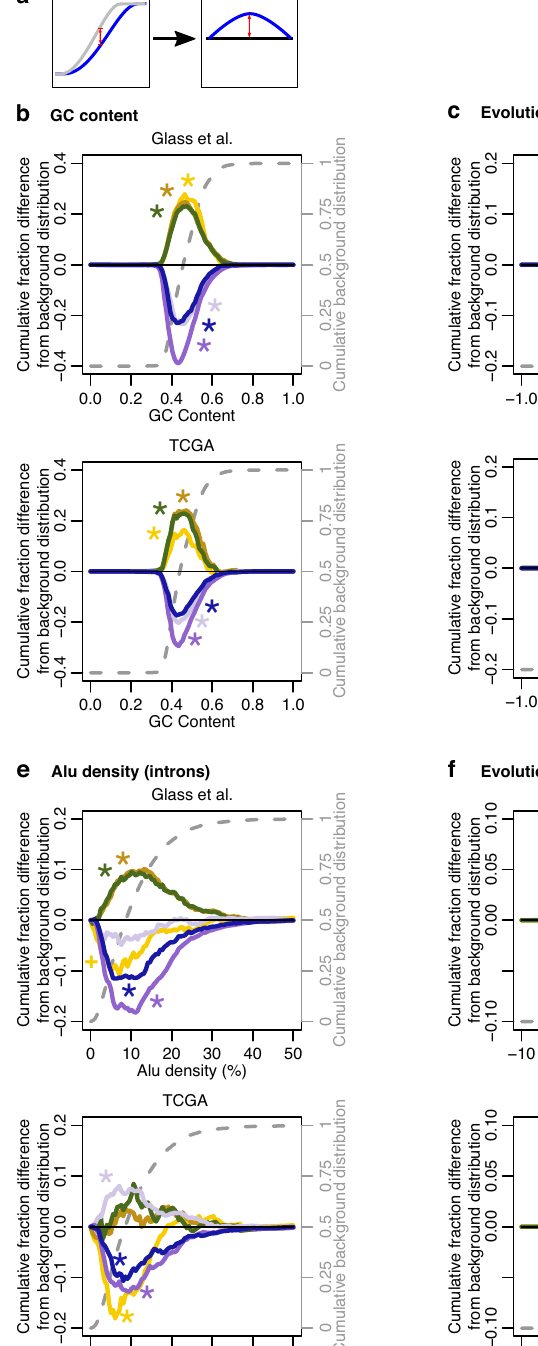
valueswhilenegativevaluesindicateashiftofthedistributiontowardlowervalues. Plots depict analyses of GC content ( b ), evolutionary conservation ( c ) and repeti- tive element densities ofMIR( d ) and Alu( e )elements, for the geneswith non-zero respective densities. f Evolutionary conservation of the mCpGs that are correlated with genes at proximal, intermediate, or long range. g Heatmap illustrating fold enrichment of the mCpGs in repetitive elements. For b – f asterisks and crosses indicate statistical signi fi cance at a p value threshold of 10 − 4 and 10 − 2 , respectively, per Kolmogorov – Smirnov tests (two-sided). For f , hypergeometric tests (one- sided) were used and a p value threshold of 2×10 − 2 . All p values are listed in Supplementary Data 4. Source data are provided as a Source Data fi